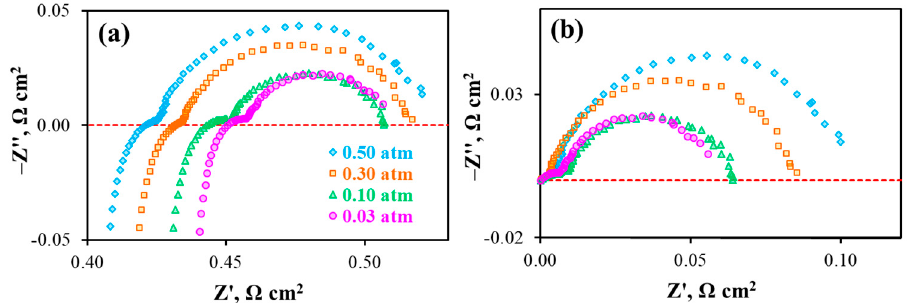
Figure A2. Impedance spectra of the PCC at 750 °C and OCV conditions depending on different pH 2 O in air atmosphere (fuel gas is 3%H 2 O/H 2 ): original spectra ( a ) and those obtained after subtracting the ohmic resistance ( b ).